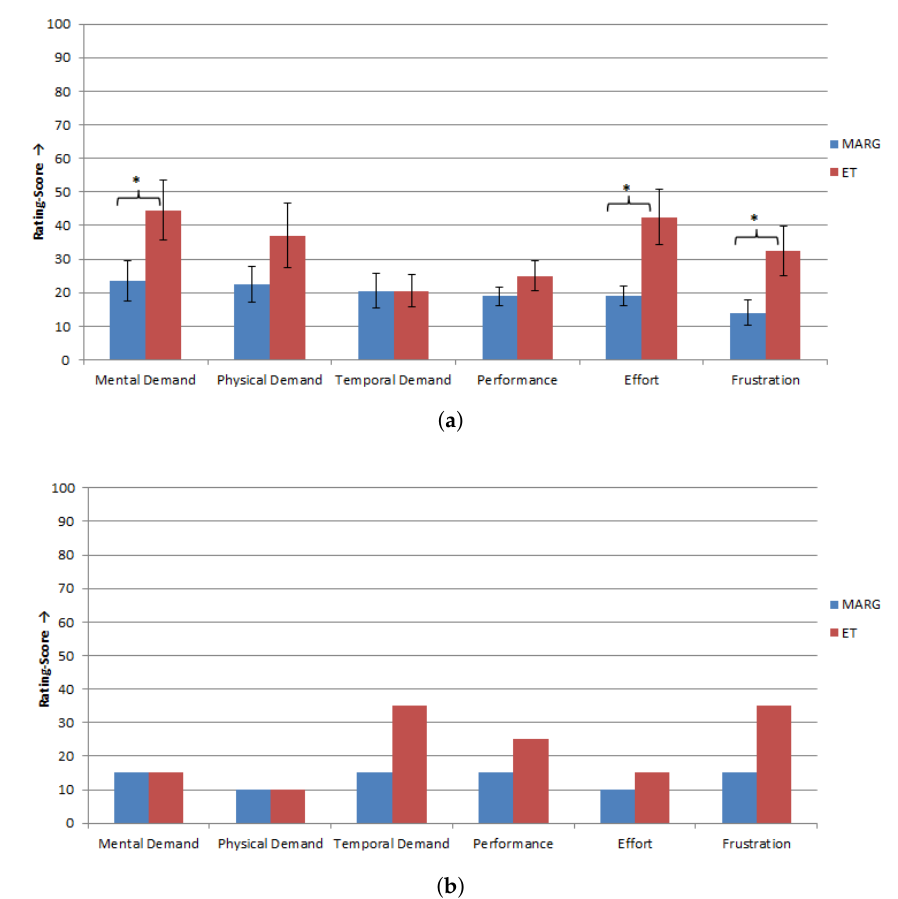
Figure 8. Results of the NASA-TLX questionnaire to measure the subjective perceived workload for Test 1, scale: 0 = low/good to 100 = high/poor: ( a ) able-bodied subjects ( n = 10), mean values ± SE of the rating scores for the six sub-scales of the NASA-TLX; and ( b ) subject with tetraplegia ( n = 1), values of the rating scores for the six sub-scales of the NASA-TLX. * Marks sig. differences ( p <